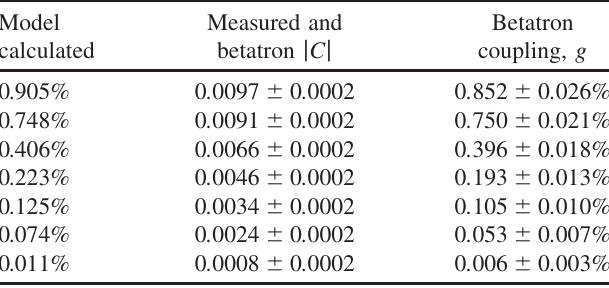
TABLE III. Results of tune crossing measurement.